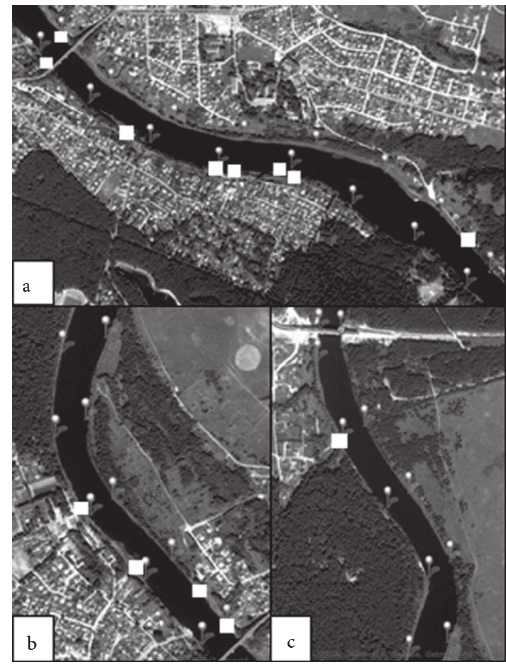
Fig. 2. Sampling locations downstream – Nemunas river above (a), middle (b) and below (c) Alytus city